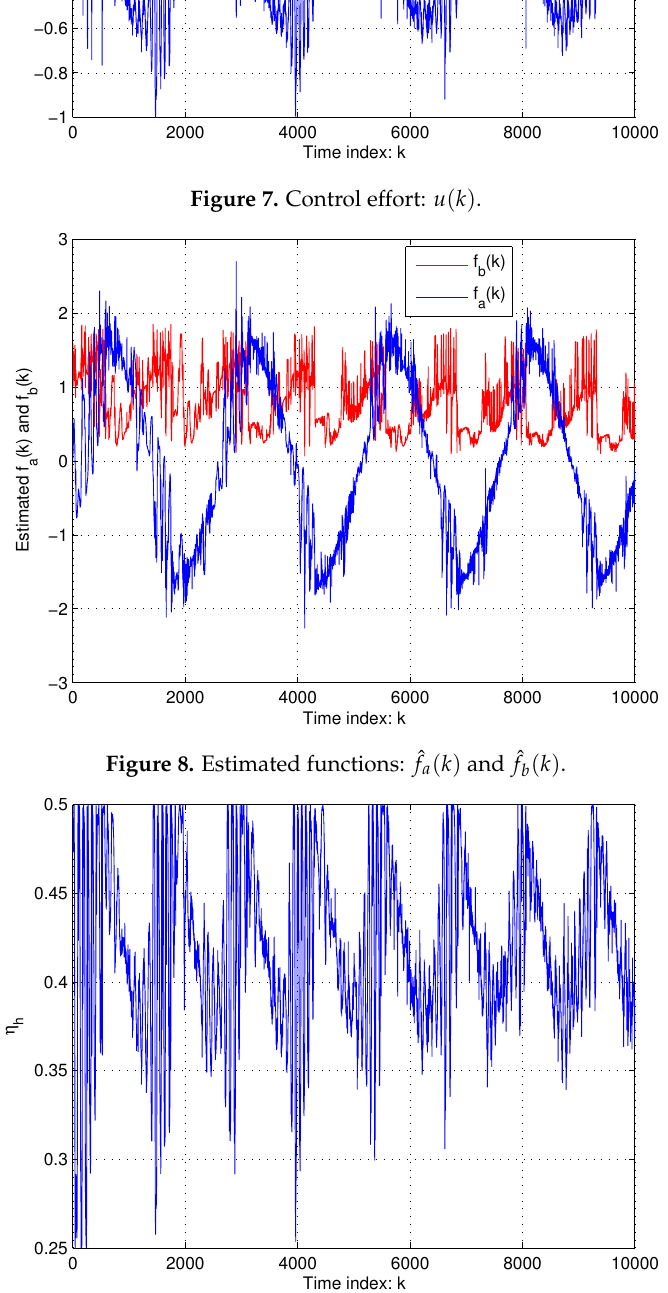
Figure 9. Learning rate of the MiFREN equivalent model: η h ( k )